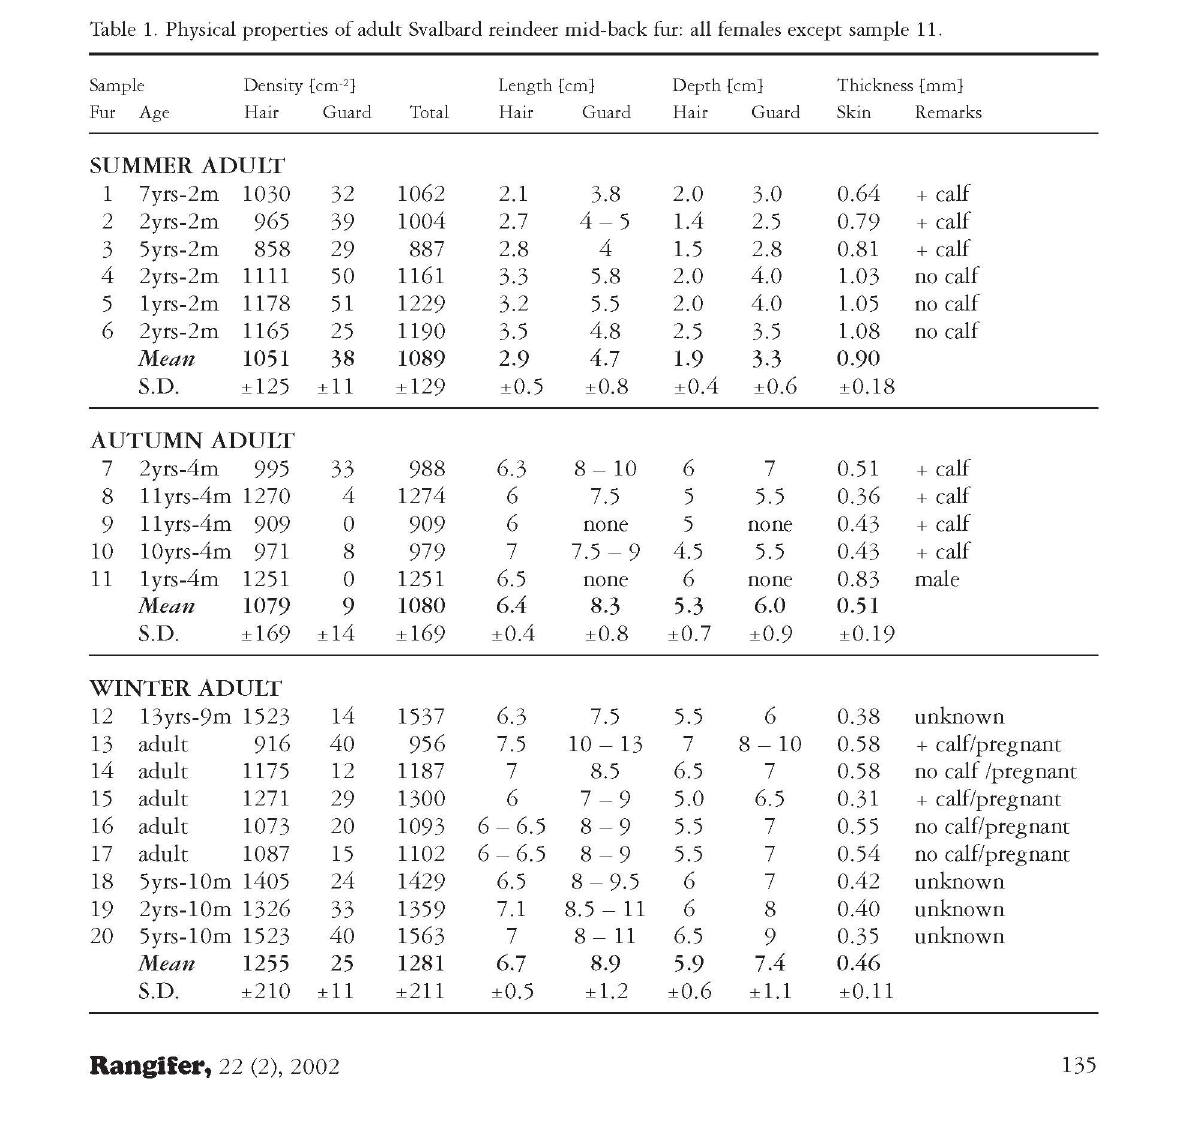
Table 1. Physical properties of adult Svalbard reindeer mid-back fur: all females except sample 11.